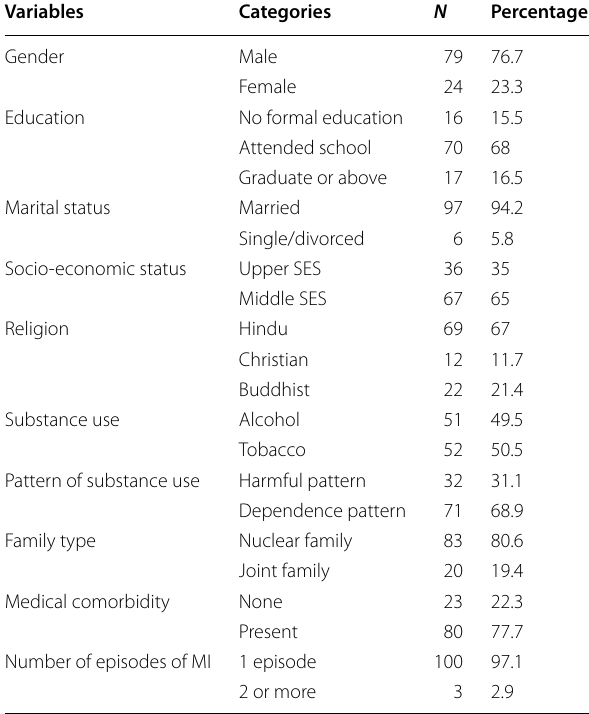
Table 1 Sociodemographic characteristics of the participants Variables